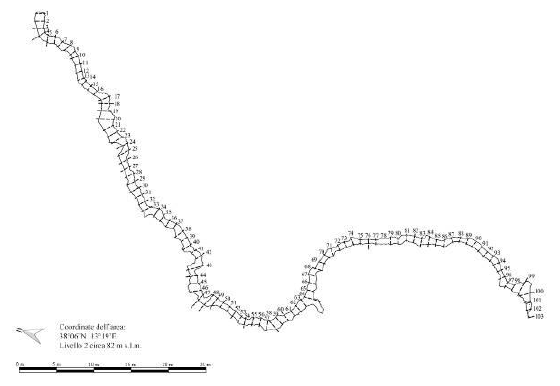
Figure 12 . The plan and the cross sections of the qanāt .